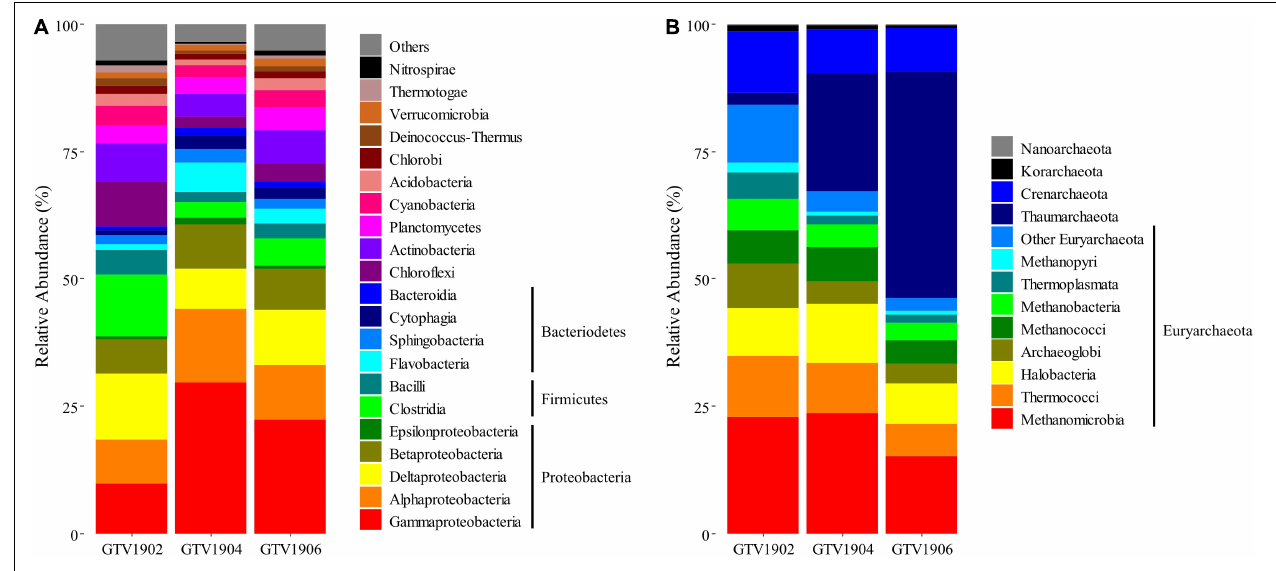
FIGURE 2 | Taxonomic composition and relative abundance of (A) Bacteria and (B) Archaea in the three different metagenomes based on protein-coding genes using RefSeq database at class level. “Others” represent those accounting for < 1% of the total hits in each sample and are shown in gray at the top of each